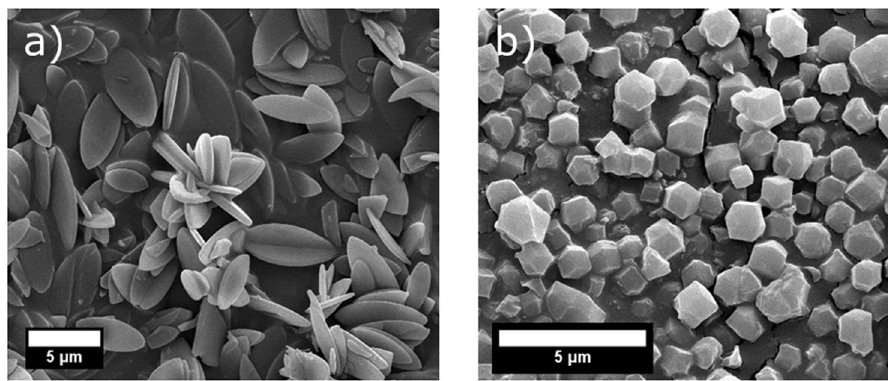
Fig. 7 SEM images of ZIF materials. SEM micrographs of a as made ZIF-L and b